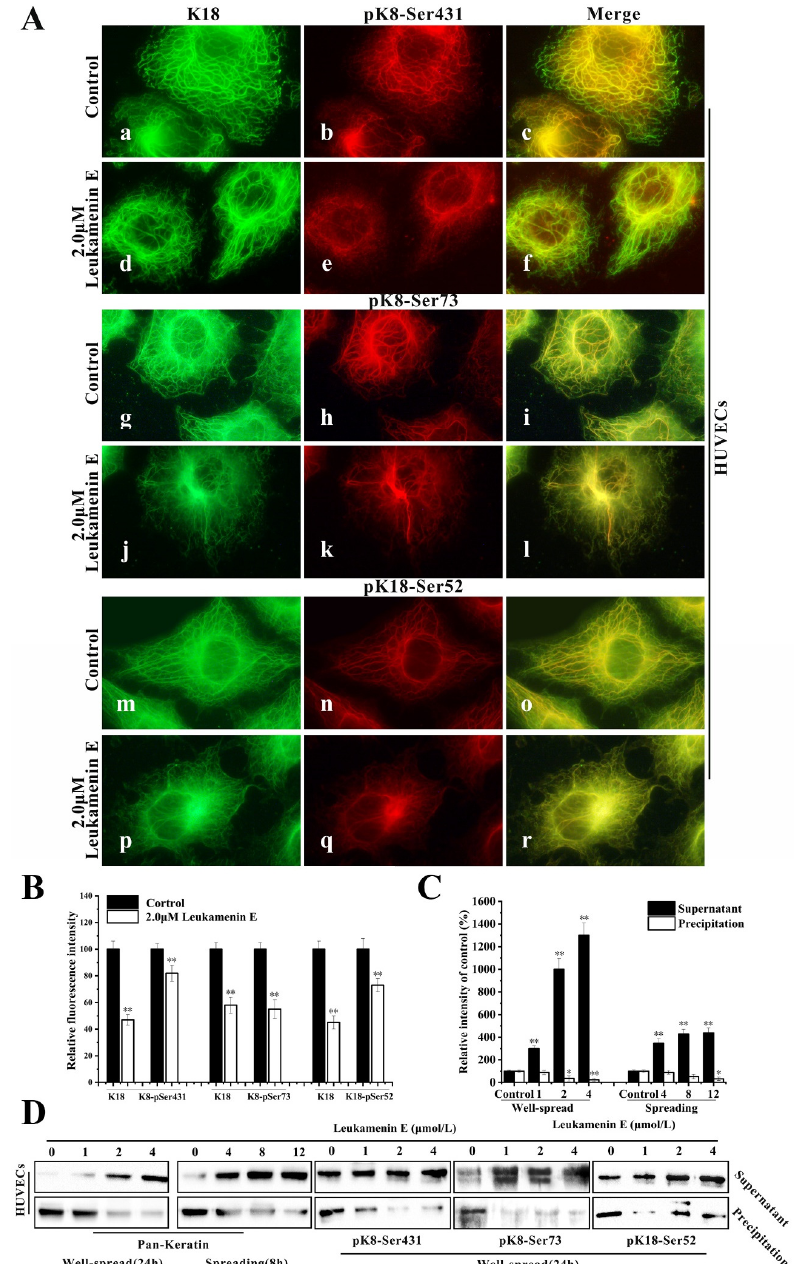
Figure 7. Leukamenin E induces phosphorylation at K8-Ser431, K8-Ser73 and K18-Ser52 to increase keratin solubility in HUVECs. ( A ) Immunofluorescence imaging shows that leukamenin E leads to increased phosphorylated KFs fraction from keratin network. Keratin immunostaining was performed using the pK8-Ser431antibody(b,e),pK8-Ser73(h,k)antibody,pK18-Ser52antibody(n,q),andK18antibody(a,d,g,j,m,p). The mergers are shown in c, f, i, l, o and r, respectively. 1000 × . ( B ) Graph depicts the quantification of K8 or phosphorylated K8 at Ser431 / Ser73 / Ser52 by fluorescence intensity analysis. ( C ) Protein content in supernatant and precipitation was determined by grey level analysis. ( D ) Cells were subsequently lysed, and the keratin content in the supernatant and pellet was analyzed by Western blotting using pan-keratin / pK8-Ser431 / pK8-Ser73 / pK18-Ser52antibody, which showed that leukamenin E increases soluble fraction of KFs or phosphorylated keratin in well-spread cells. Images represent typical cells from at least three independent experiments. The data shown represent the means ± standard deviation (S.D.) of three independent experiments. * p < 0.05, ** p < 0.01, ν ersus the control